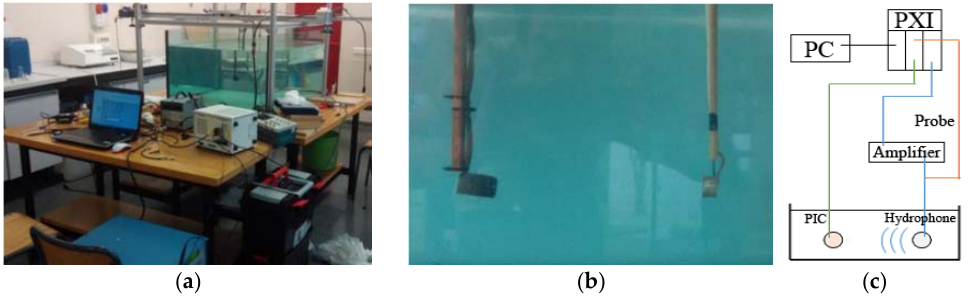
Figure 6. Configuration 1: measurements in the water tank. ( a ) The experimental setup; ( b ) image of the calibration of a ceramic with an FFR SX30 reference hydrophone; ( c ) scheme of the experimental setup.